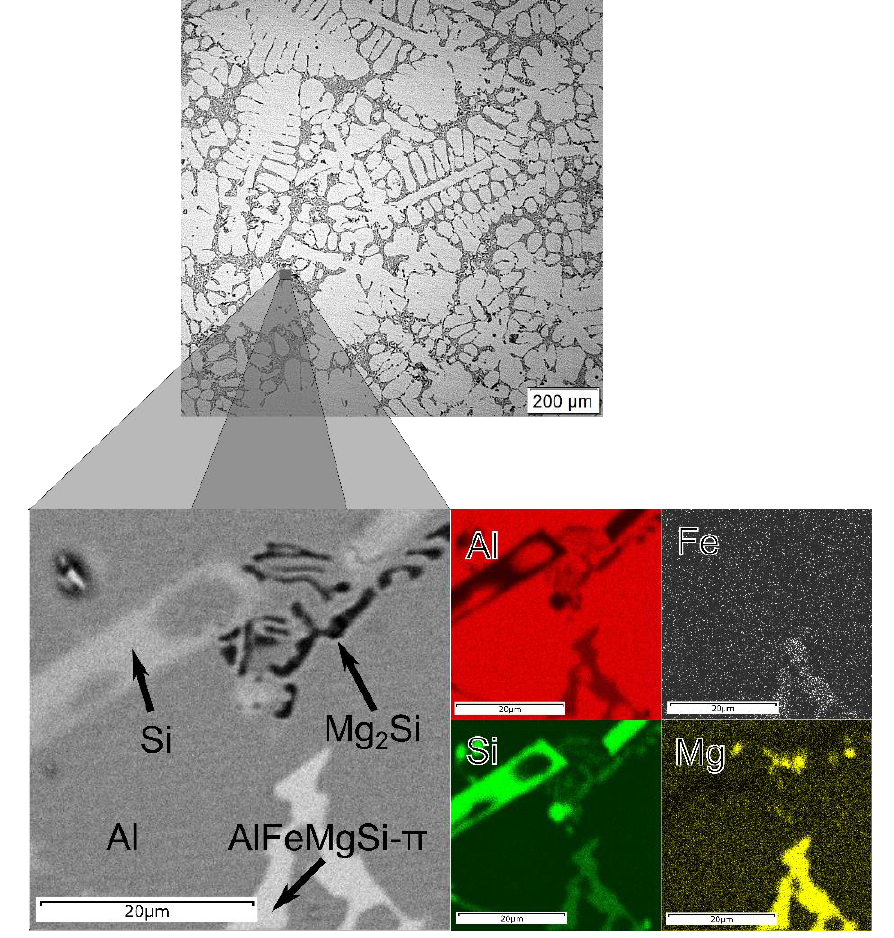
Figure 7. Characteristic SEM micrograph with an EDS analysis showing the microstructure phases.